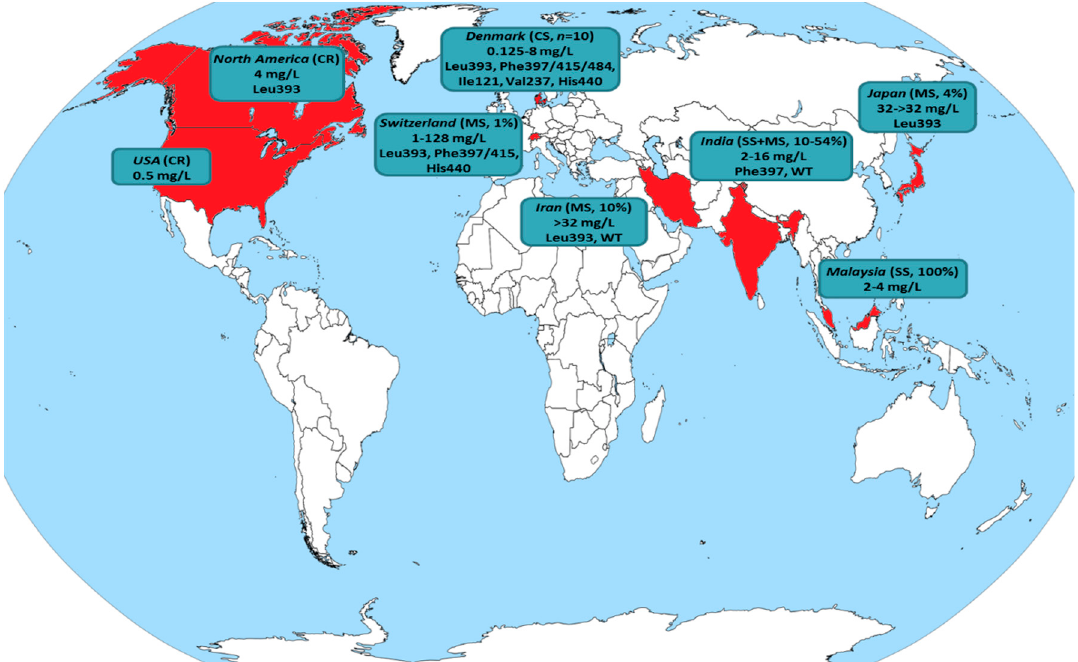
Figure 3. Global distribution of T. rubrum isolates exhibiting reduced susceptibility to terbinafine (detailed in Table 3). The country of origin is colored in red, while the type of study (case report: CR, case series: CS, single-center study: SS, multicenter study: MS) along with the recovery rate of isolates displaying non-wild-type (WT) phenotype, terbinafine minimum inhibitory concentrations (mg/L) and amino acid positions with hot-spot mutations in the squalene epoxidase target gene (where available) are presented.